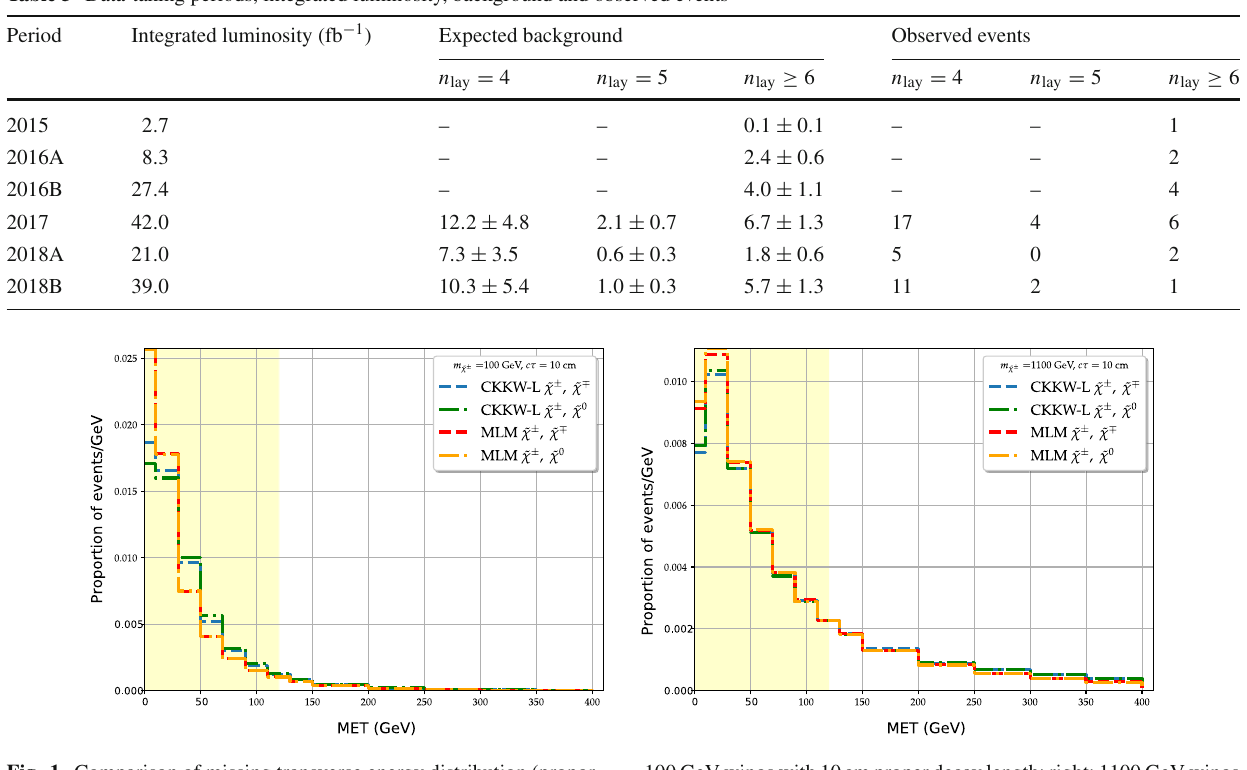
100 GeV winos with 10cm proper decay length; right: 1100 GeV winos with 10cm proper decay length. Not shown is the overflow